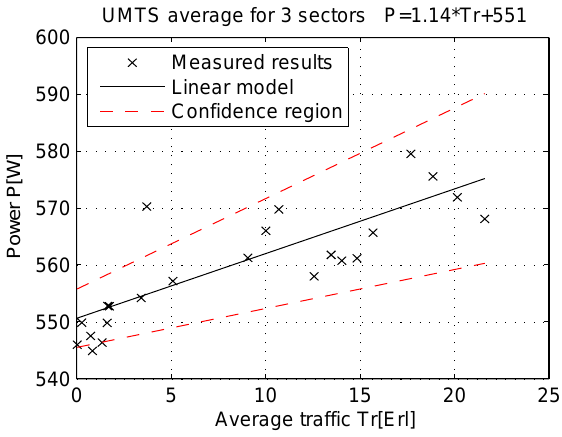
Figure 33. Power consumption model for UMTS BS rack (Monday,